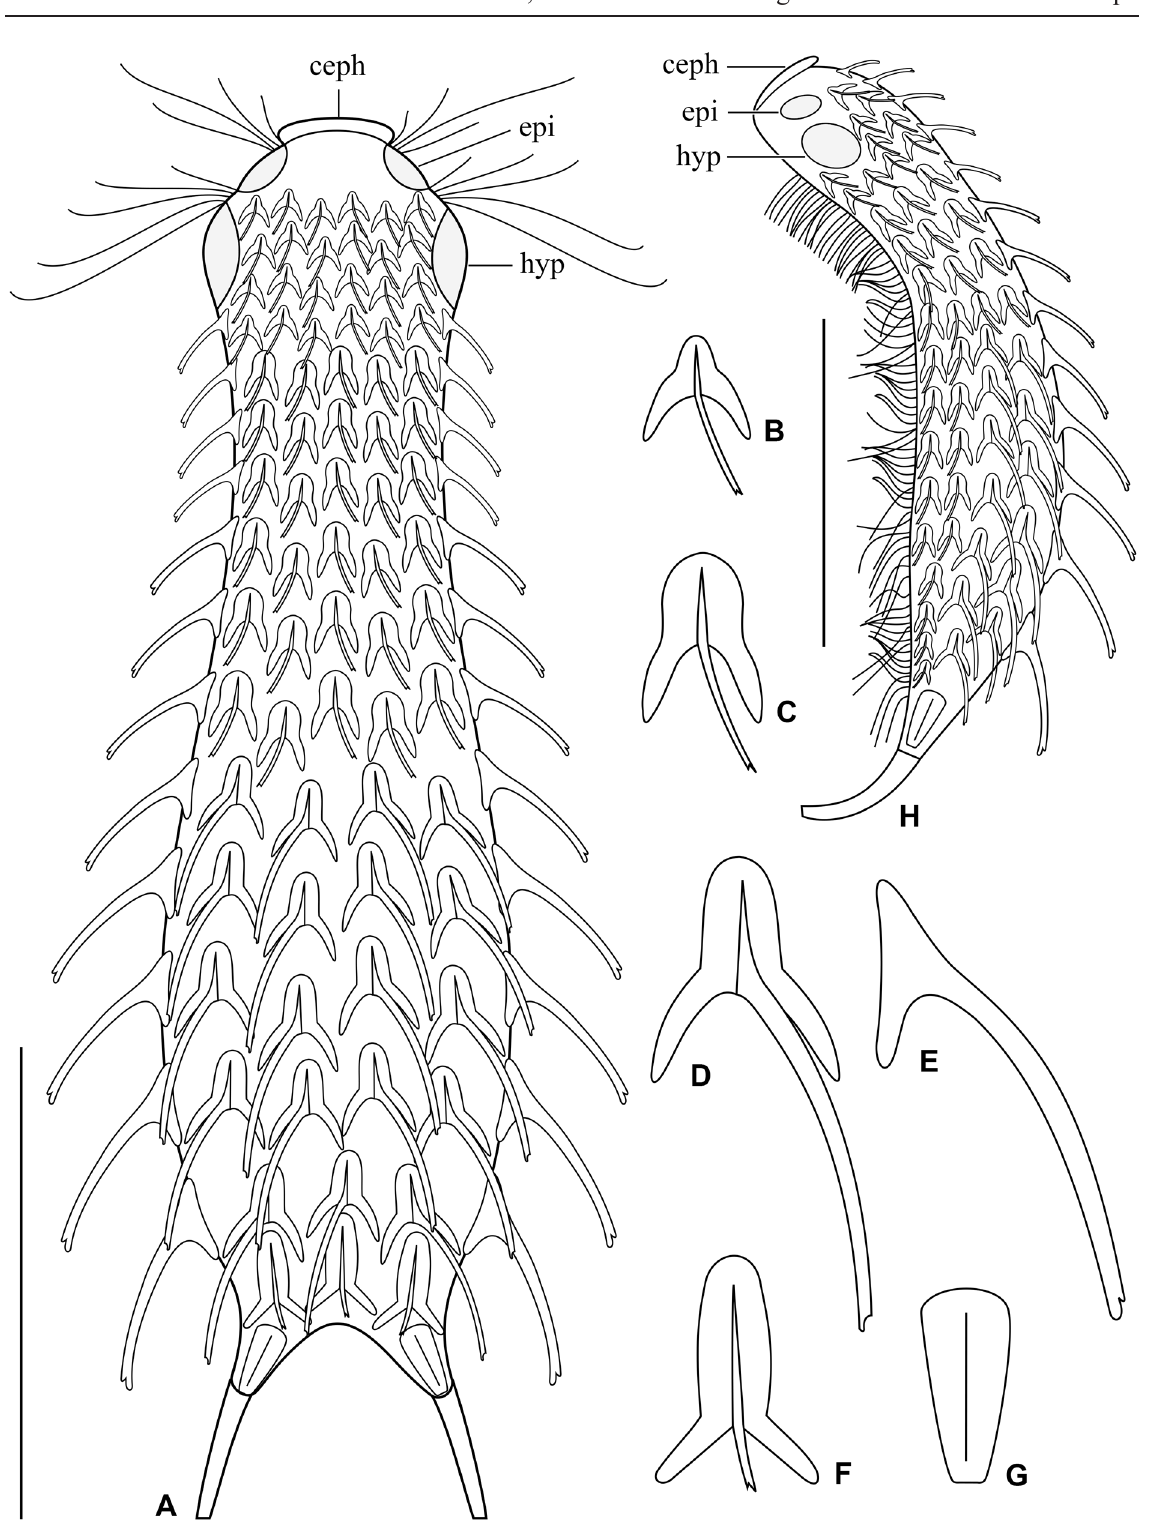
Fig. 28. Chaetonotus ( Hystricochaetonotus ) luxus sp. nov. A , H . Dorsal and lateral overviews showing the scale and spine pattern. B . Head scale. C . Neck and upper-trunk scale. D – E . Frontal and lateral views of a trunk spined scale. F . Posterior trunk scale. G . Dorsal furcal scale. Scale bars = 30